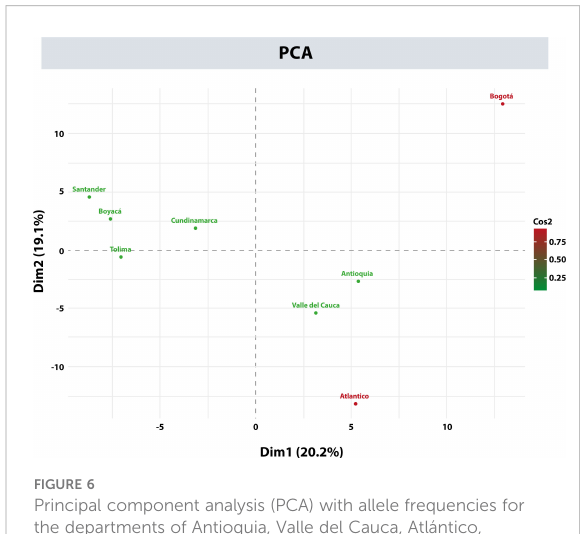
FIGURE 6 Principal component analysis (PCA) with allele frequencies